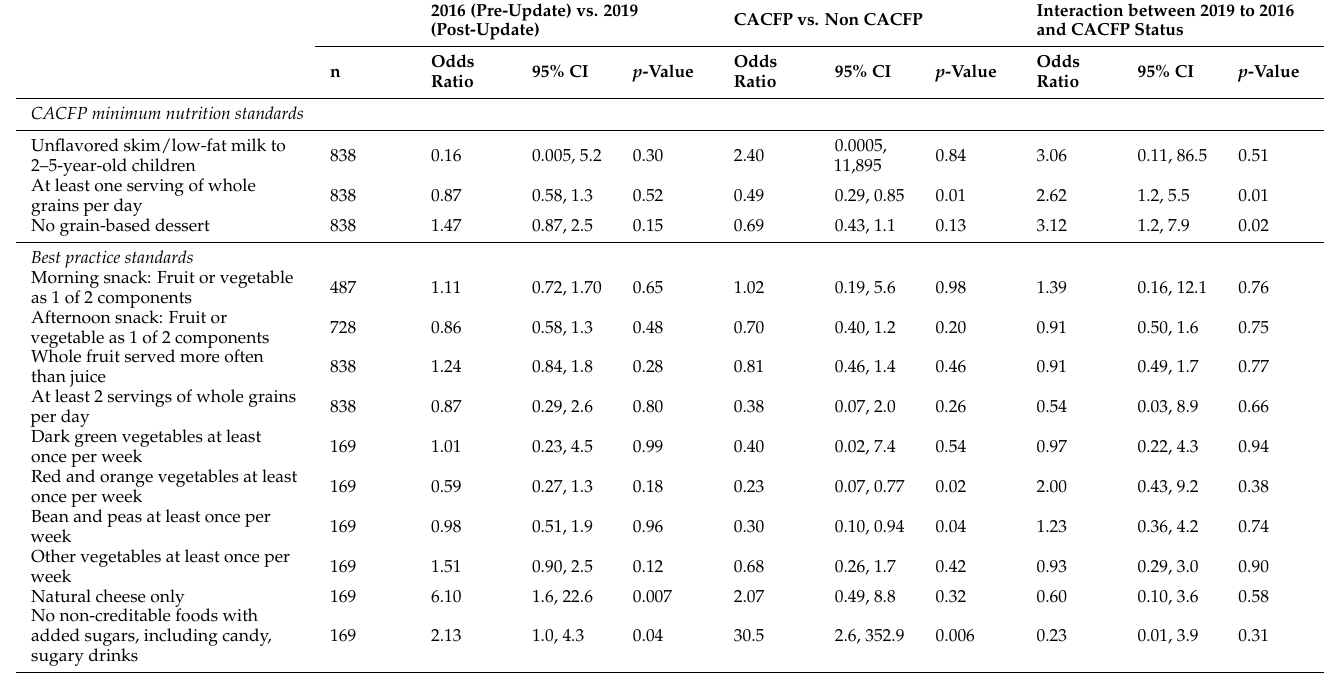
Table A2. Difference-in-difference model results: centers servings snacks